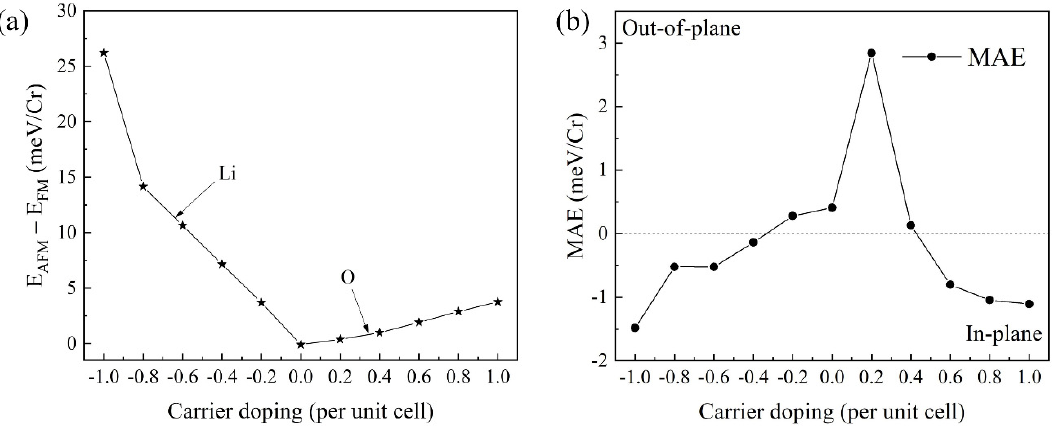
Figure 5. ( a ) Energy difference in the AFM and FM states ( E AFM − E FM ) for the CrI 3 bilayer under carrier doping. Along the x -axis, a positive (negative) value represents hole (electron) doping. On the y -axis, positive (negative) value of energy represents FM (AFM) coupling in the CrI 3 bilayer. ( b ) The MAE of the CrI 3 bilayer with different carrier doping.